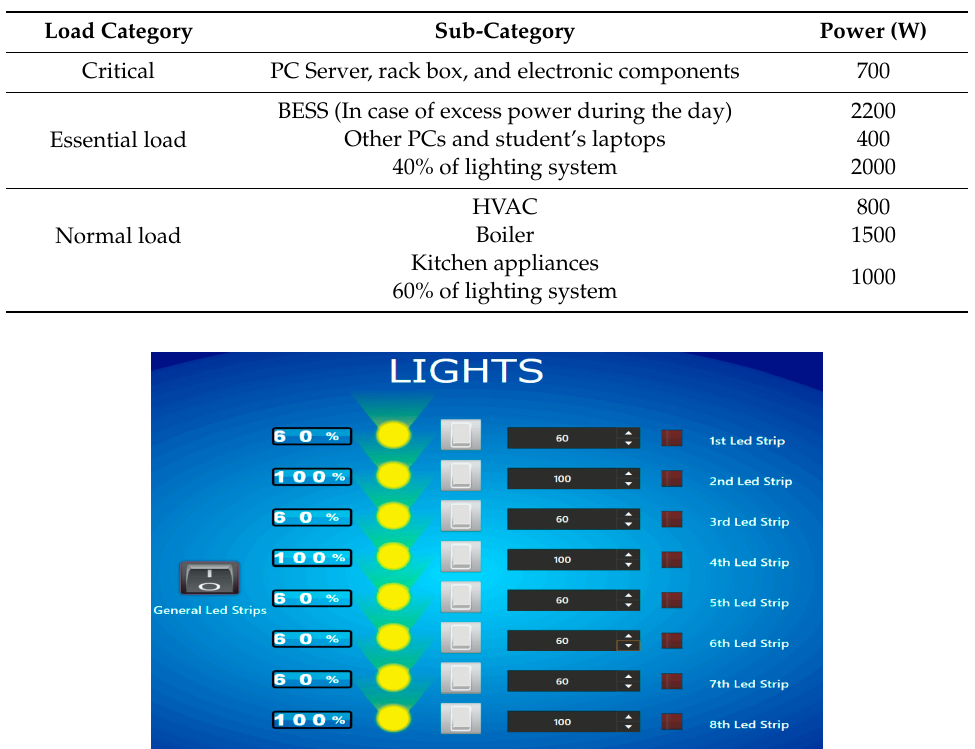
Table 1. Load categories with details. 170